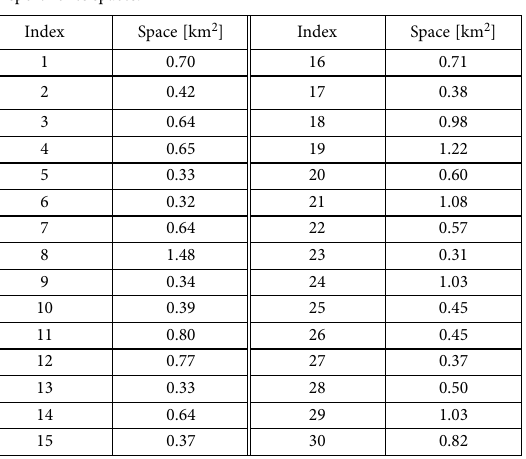
Transport zones